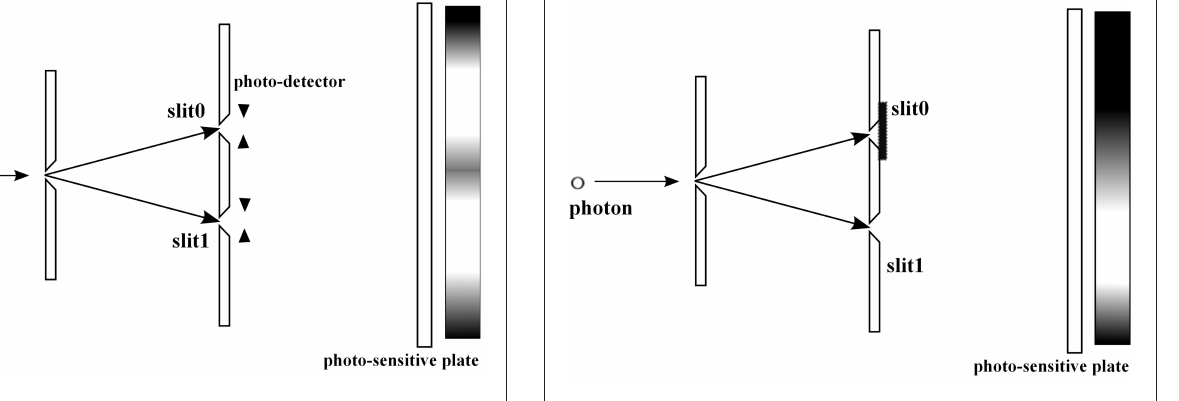
FIGURE 5 | Two slit experiment.